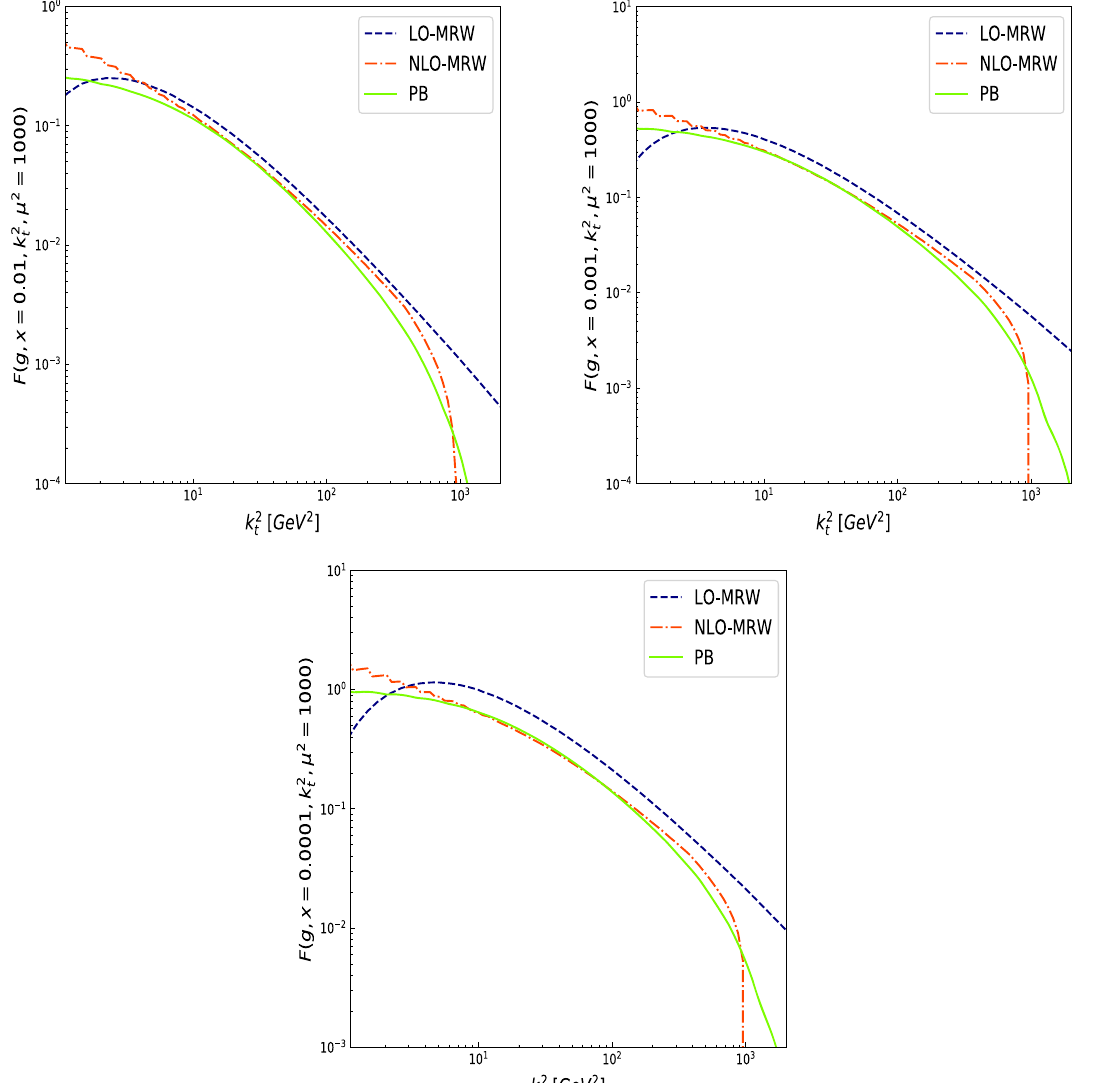
Fig. 2 The plots of LO-MRW, NLO-MRW and PB gluon UPDFs with respect to k 2 t for different x values as denoted in each plot are